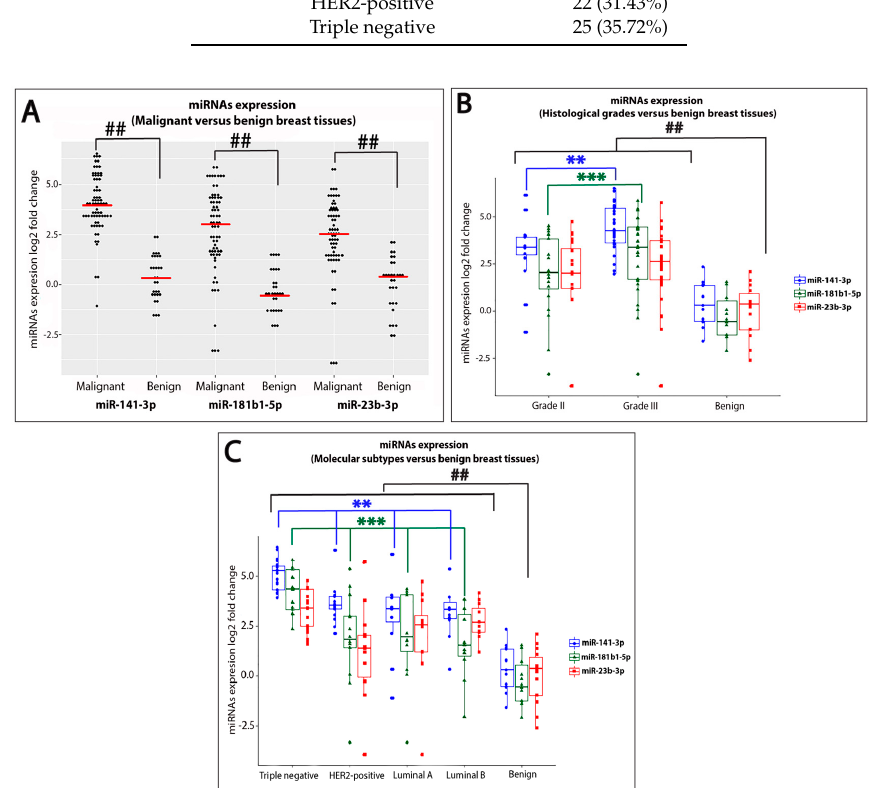
Figure 1. Comparisons of miR-141-3p, miR-181b1-5p, and miR-23b-3p in di ff erent groups of breast tissues. ( A ) Significant high expression levels ( p < 0.0001) of miR-141-3p, miR-181b1-5p, and miR-23b-3p were detected in breast cancer tissues in comparison with benign breast fibroadenomas. ( B ) Significant high expression levels ( p < 0.0001) of miR-141-3p, miR-181b1-5p, and miR-23b-3p were detected in grades II and III breast cancer when compared with benign breast fibroadenomas. Moreover, significant high expression ( p < 0.05) of miR-141-3p and miR-181b1-5p was associated with high-grade breast tumors (grade III) in comparison to grade II breast cancer. ( C ) Significant high expression levels of miR-141-3p, miR-181b1-5p, and miR-23b-3p were detected in TNBC, HER2-positive, luminal A, and luminal B compared with benign controls. In addition, significant high expression ( p < 0.05) of miR-141-3p and miR-181b1-5p in TNBC was detected compared with HER2-positive, luminal A, and luminal B subtypes. ## indicates significant di ff erence between malignant and benign breast tissues ( p < 0.0001), ** indicates significant di ff erence in miR-141-3p expression ( p < 0.05), *** indicates significant di ff erence in miR-181b1-5p expression ( p <